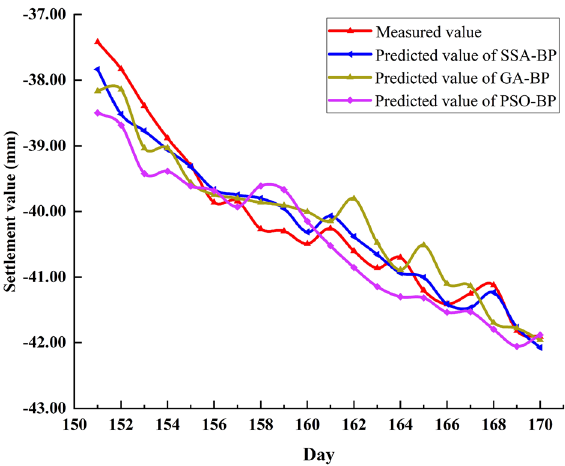
Figure 13. Comparison of predicted values of SSA-BP, GA-BP and PSO-BP at P2.